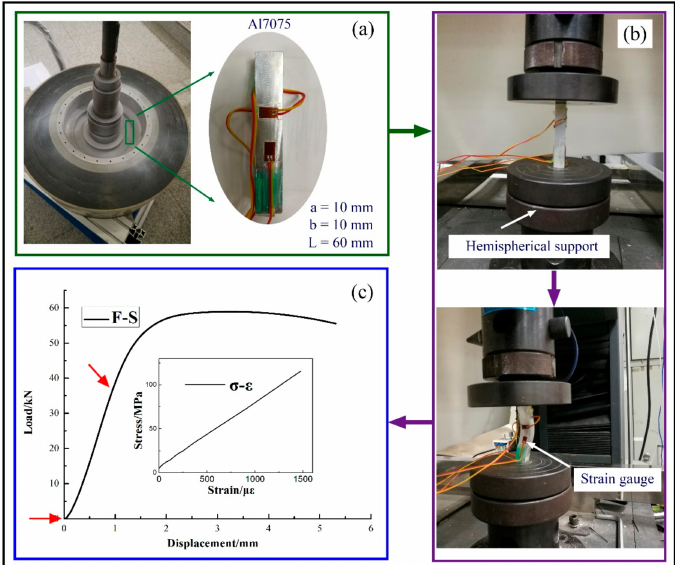
Figure 3. Characterization of mandrel material properties: ( a ) sample location and dimension; ( b ) test procedure; and ( c ) test results.